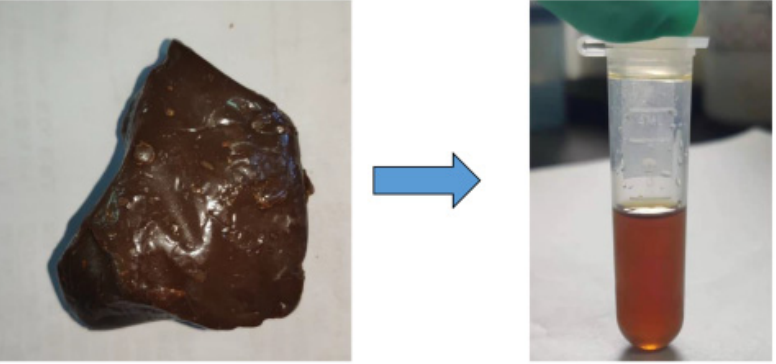
Figure 1. Chinese red propolis extracts from Shandong, China. Left is Chinese red propolis extract, right is Chinese red propolis extract dissolved in methanol.